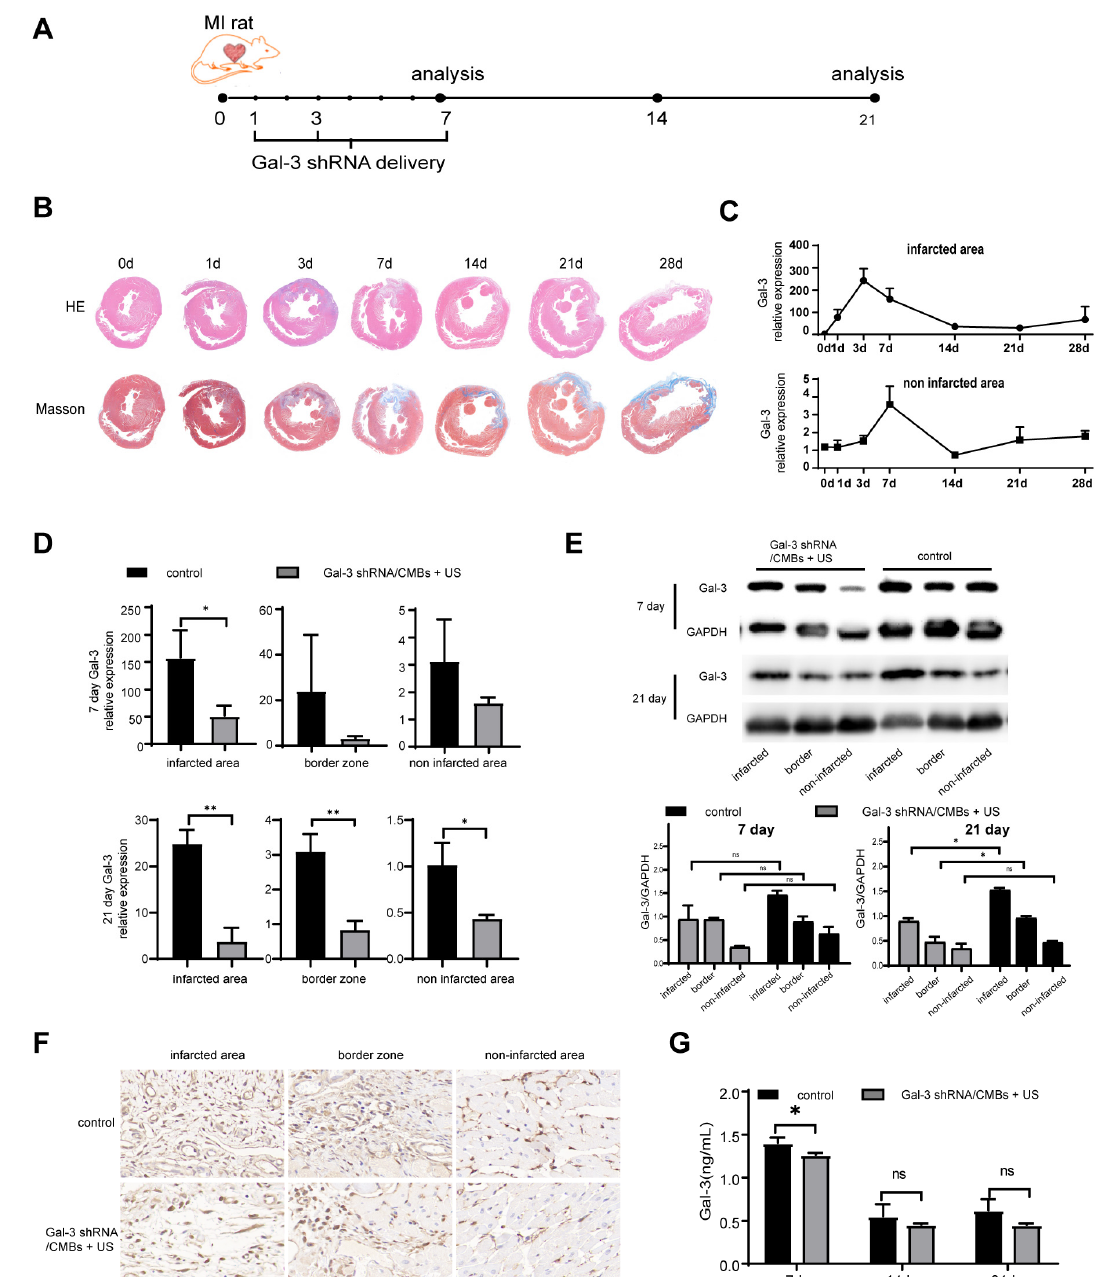
Figure 3. Gal-3 expression in myocardium. ( A ) Therapy regimen schematic of Ultrasonic Microbubble Cavitation-mediated Gal-3 shRNA delivery in MI rats. ( B ) HE staining and Masson trichrome staining of hearts sectioned at mid-ventricle at 0, 1, 3, 7, 14, 21, 28 days post-MI. ( C ) Temporal changes in Gal-3 mRNA expression post-MI. ( D ) Myocardial Gal-3 mRNA level in Gal-3 shRNA/CMBs + US group and control group. ( E ) Gal-3 protein expression in Gal-3 shRNA/CMBs + US group and control group. ( F ) Immunohistochemistry staining with Gal-3+ cells on day 21. ( G ) Concentration of Gal-3 in serum. Infarcted represents the infarcted area, border represents the border zone, and non-infarcted represents the non-infarcted area ( n = 3, ns p > 0.05, * p < 0.05, ** p <